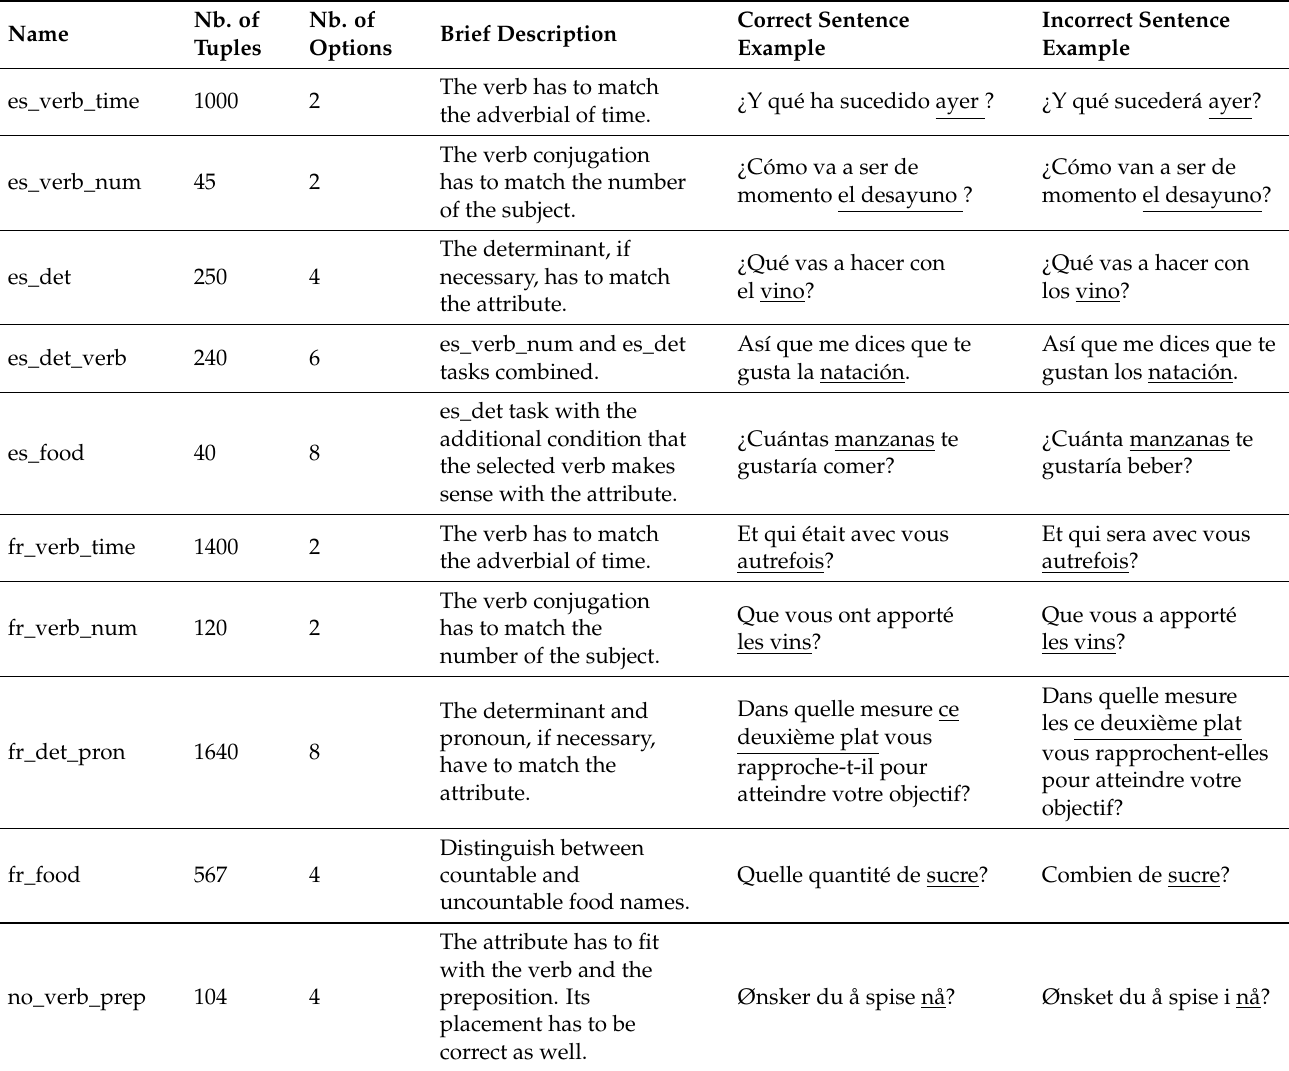
Table A1. Summary of the tasks to analyse the LMs’ performance at selecting the correct template given an attribute. In the examples, the attribute is